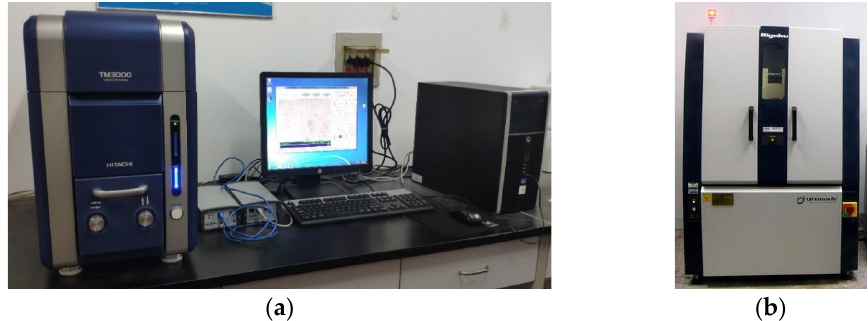
Figure 7. Microanalysis test. ( a ) Scanning electron microscope. ( b ) X-ray diffraction.